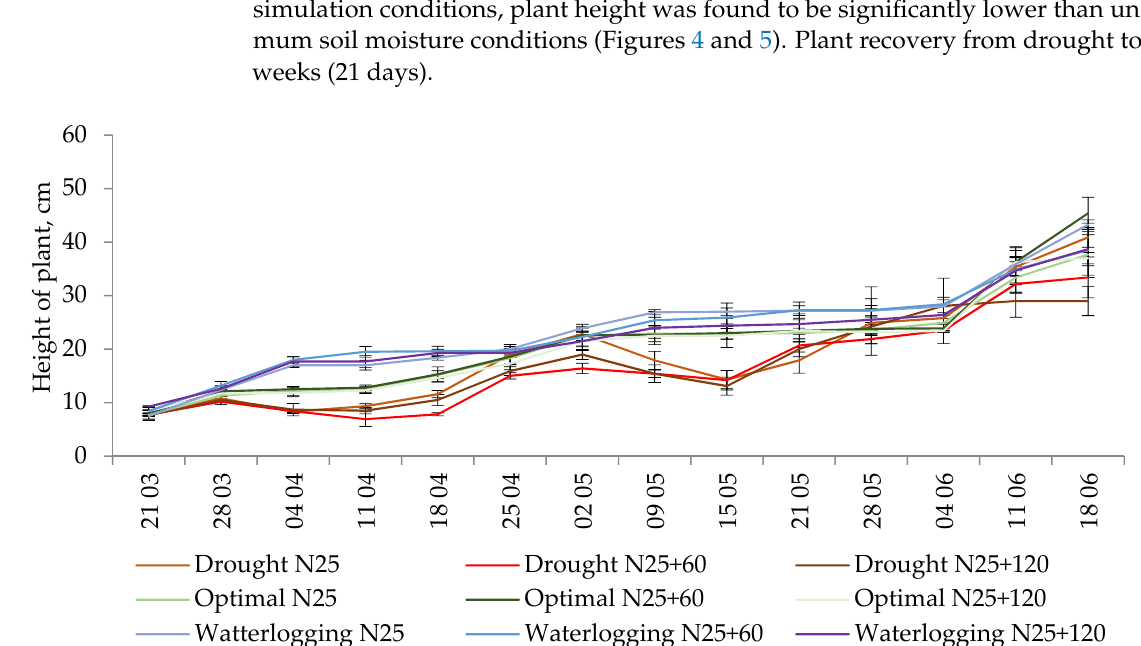
Figure 4. Growing dynamics of red clover. Note, whiskers indicate standard errors of the means.